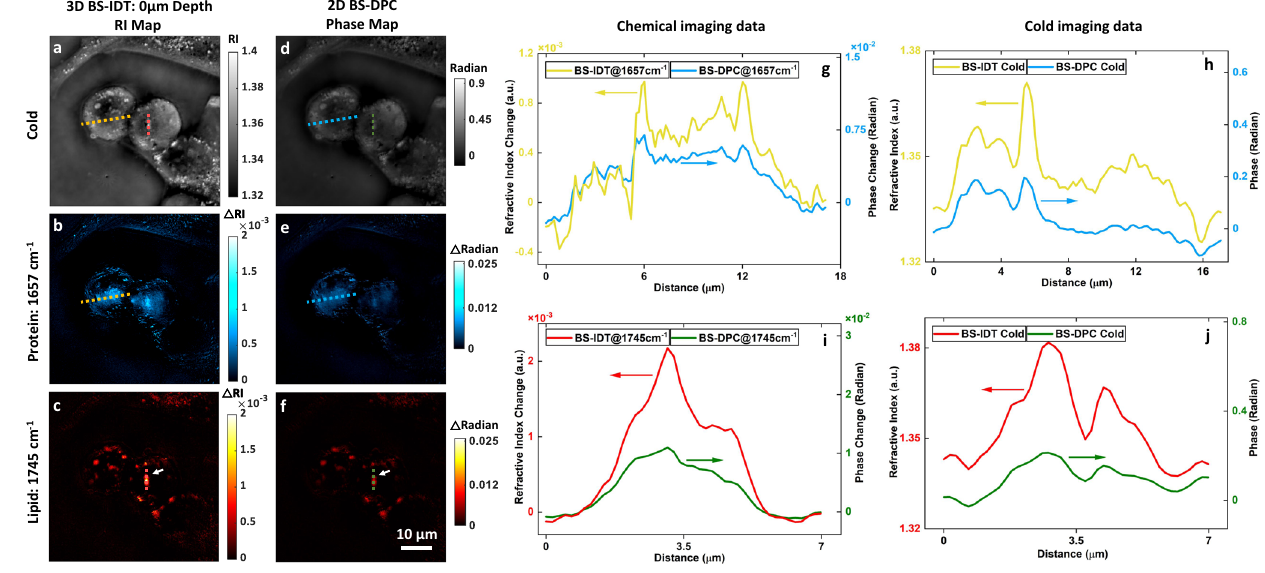
Fig. 4 | Comparison of BS-IDT and BS-DPC microscopy. a – c BS-IDT cold and chemical 3D RI reconstruction results sectioned at 0 µ m depth. Sample: fi xed mitotic bladder cancer cells in D 2 O PBS. d – f BS-DPC cold and chemical 2D phase reconstruction resultsofthe same sample. Forimages in “ a – c ” and “ d – f ” , eachrow corresponds to the same mid-IR radiation. g , i are line pro fi les extracted from the chemical imaging results of BS-IDT and BS-DPC. g Yellow-color pro fi le line is extracted from the yellow dash-line area of “ b ” . Blue-color pro fi le line is extracted